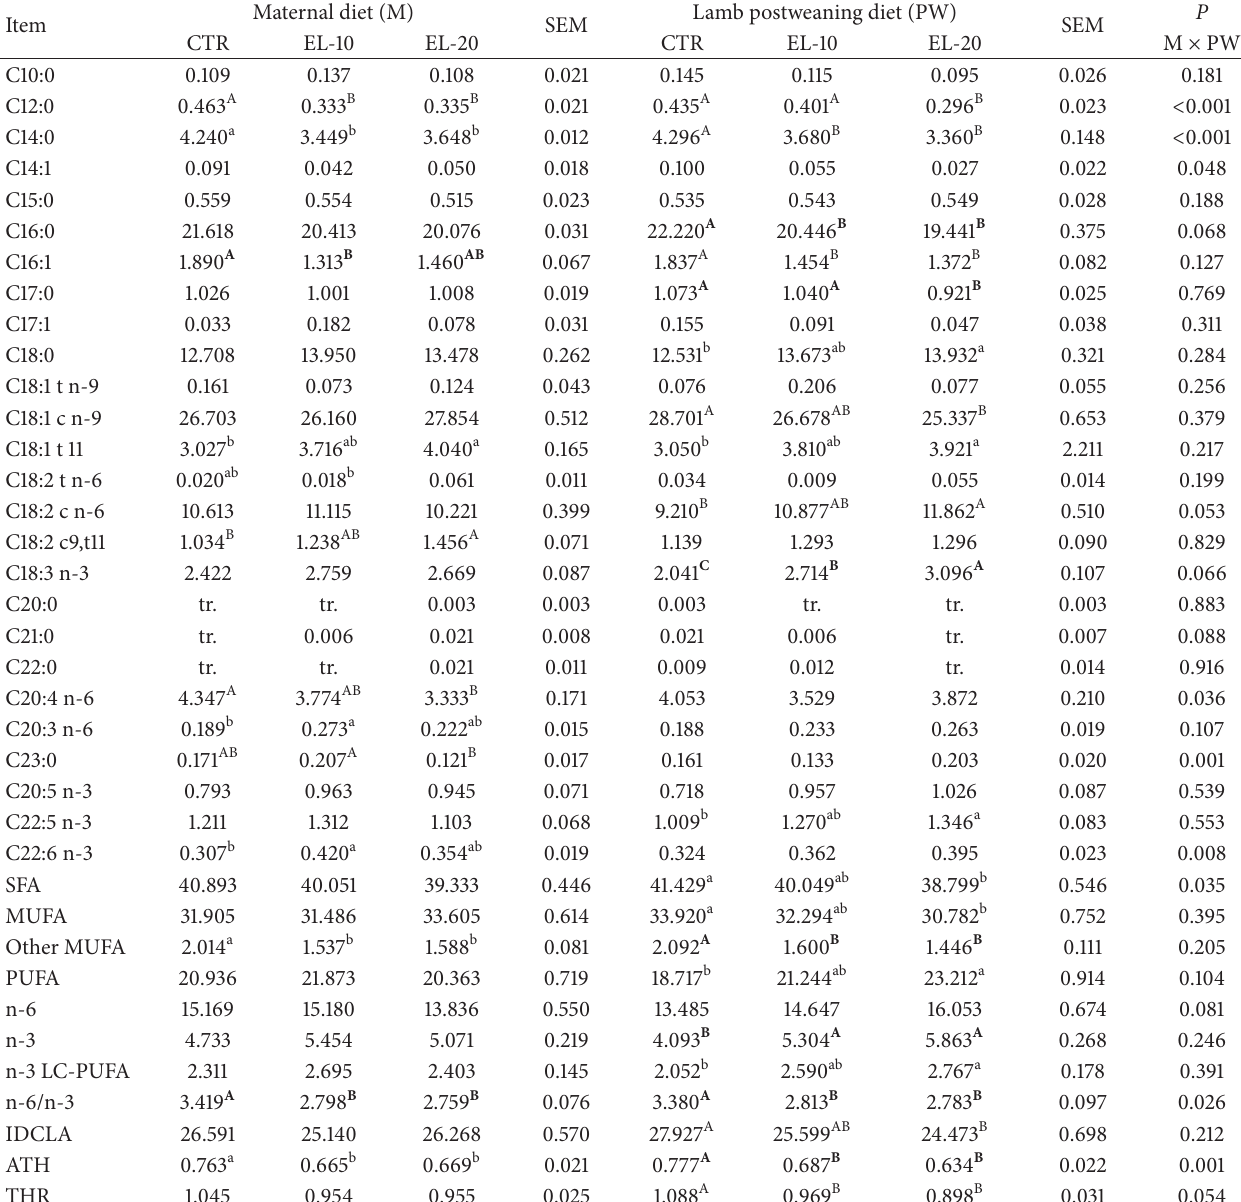
Table 5: Effect of maternal or lamb postweaning diet on the fatty acid composition of light lamb meat (g/100g of fatty acids methyl esters).